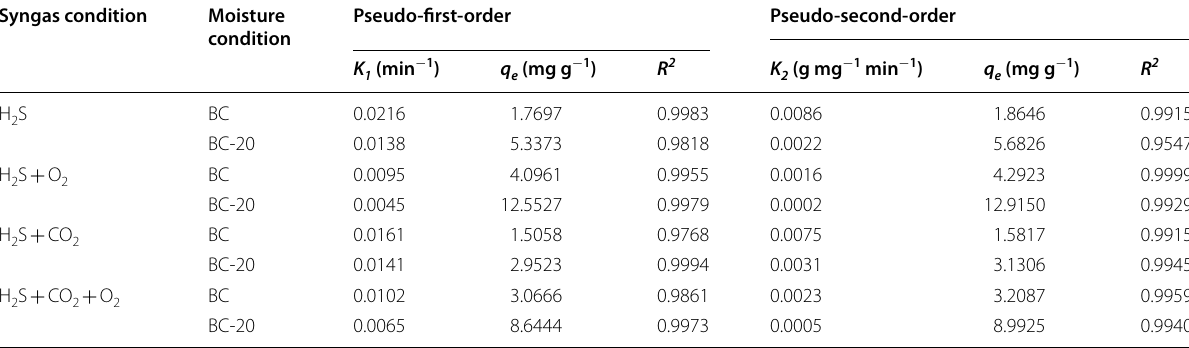
Table 4 Adsorption kinetics of the DFW-BC under different syngas and moisture conditions Syngas